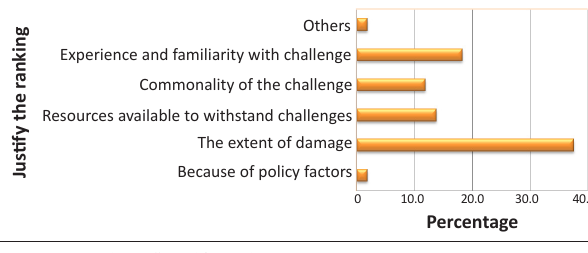
FIGURE 12: Reasons for hazard